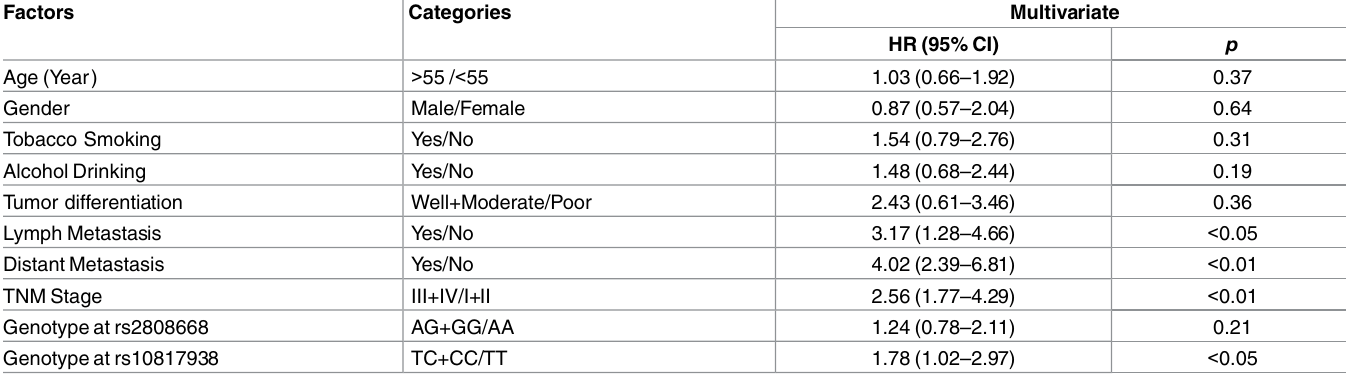
Table 4. Multivariate Cox proportional hazard analysisof prognosticfactorsfor OSCC patient